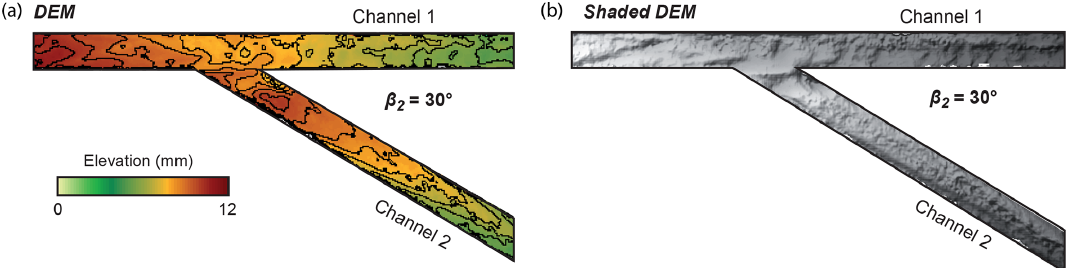
Figure 5. Final topography of Experiment 5 showing the active (1) and disconnected (2) channels. (a) Elevation DEM. (b) Shaded relief of the same DEM. Contour lines represent 1.5mm